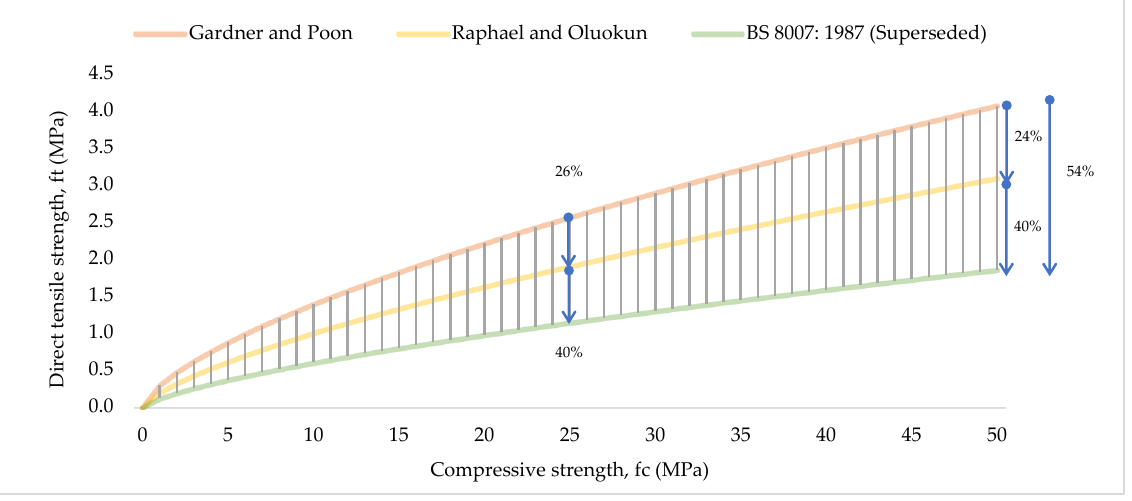
Figure 2. Correlation between Direct tensile strength and Compressive strength (Equations (9)–(11)) [43] .